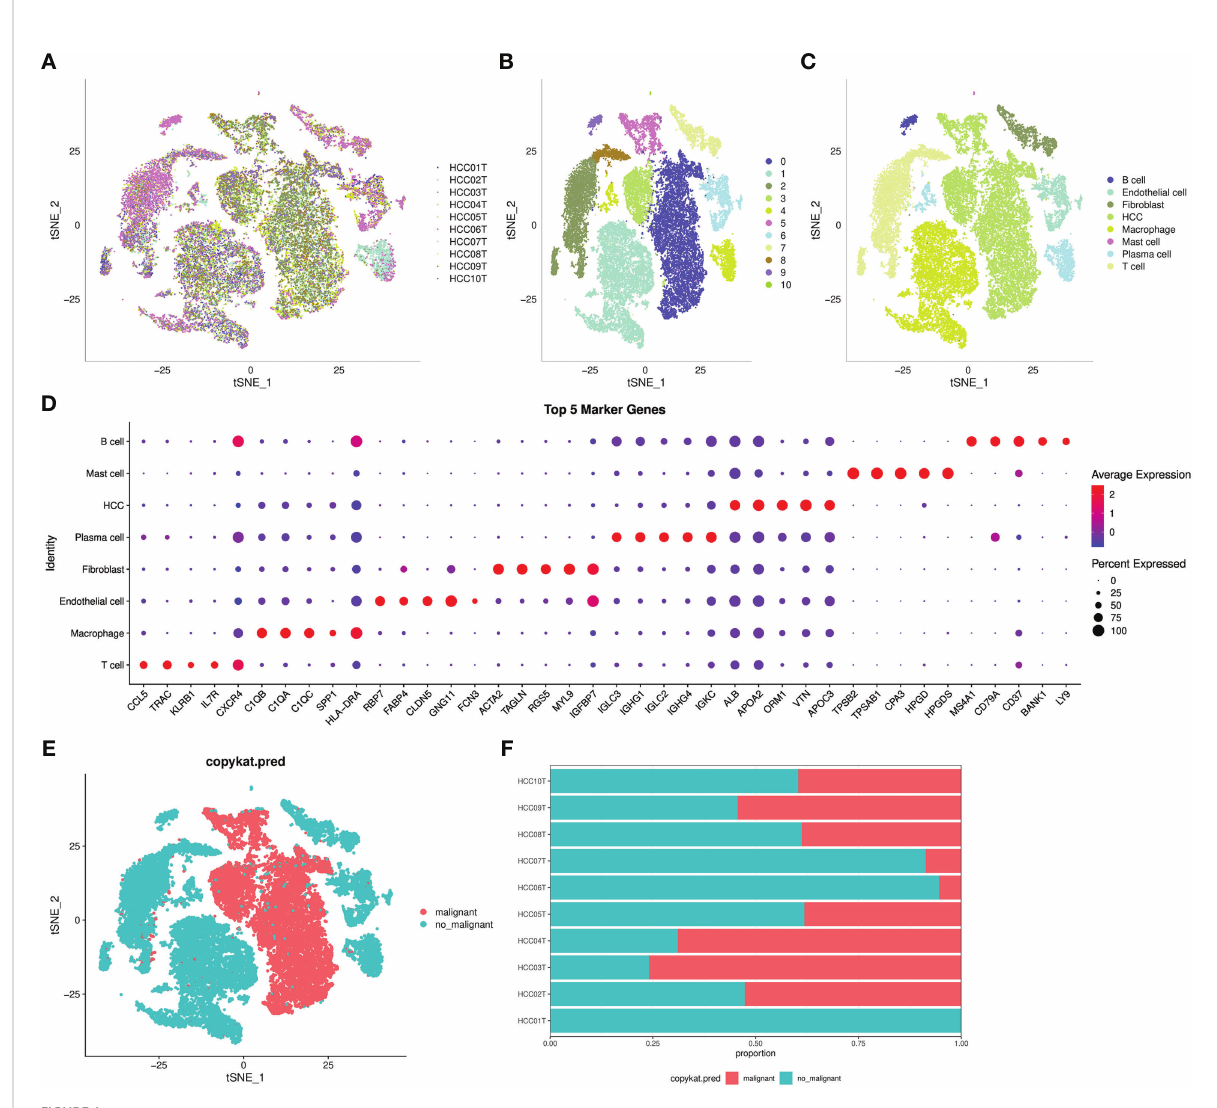
FIGURE 1 De fi nition of cell clusters. (A) t-SNE of 10 samples in the GSE149614 dataset. (B) t-SNE of 11 cell subgroups. (C) t-SNE of eight cell types. (D) Top fi ve genes that made the most signi fi cant contribution. (E) t-SNE of malignant and no_maliganant. (F) The proportion of malignant and no_maliganant in 10 samples in the GSE149614